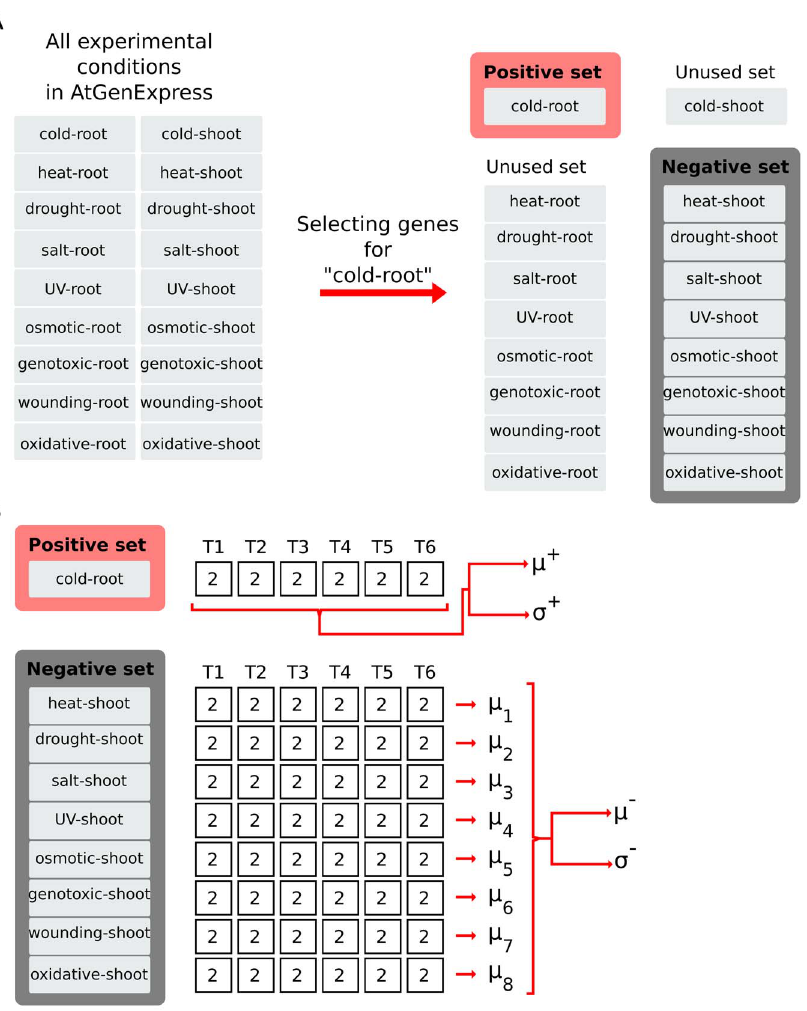
Figure 1. Example showing the calculation of the rSNR for the experimental condition ‘‘cold-root’’ in the AtGenExpress dataset. A) Division of the training dataset into positive and negative sets. The positive set corresponds to the experimental condition of interest (i.e., ‘‘cold-root’’, in red). Only some of the remaining experimental conditions in the training set, namely those not involving any of the experimental factors that define the experimental condition of interest, are used to build the negative set (in dark gray). B) Calculation of the mean and standard deviation for the positive and negative sets. T1 to T6 are time points. Numbers inside the boxes represent the number of replicates for an experimental condition at a given time point. m and s represents the mean and standard deviation respectively. For the positive set, we compute a mean and a standard deviation at each time point. For the negative set, we compute a mean at each time point. We then compute the mean and the standard deviation of the negative set as the mean and the standard deviation of the means computed at each time point